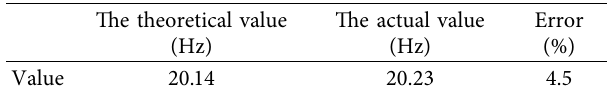
Table 8: In the condition of pose 2, Case (c), the theoretical value of the first-order natural frequency of the electrohydraulic Stewart platform is compared with the experimental value.